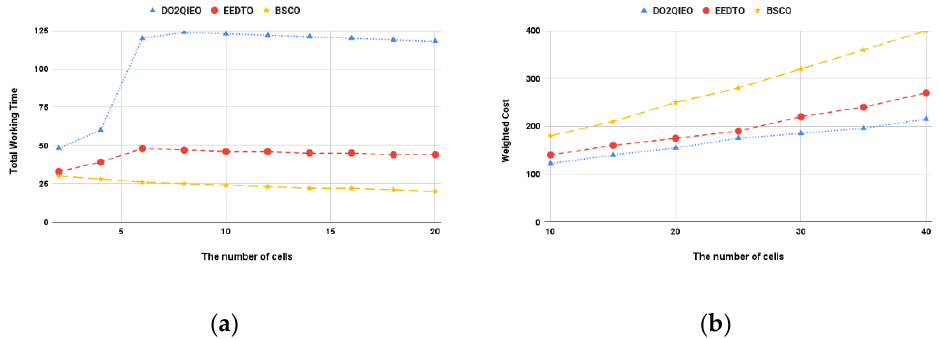
Figure 7. ( a ) The total working time of the system ( b ) and the system’s weighted cost for the given number of cells (Figure ( a ) is on the left, Figure ( b ) is on the right).